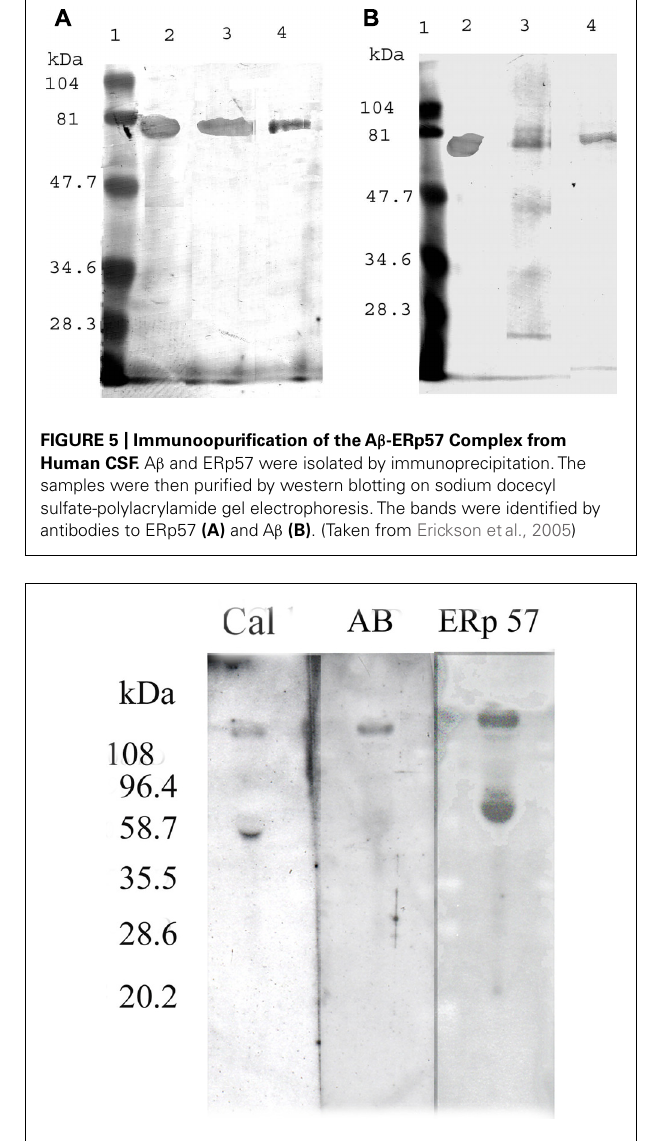
FIGURE 6 |Western blot of theA β –ERp57–calreticulin complex from human CSF after separation on a native gel (taken from Erickson etal.,